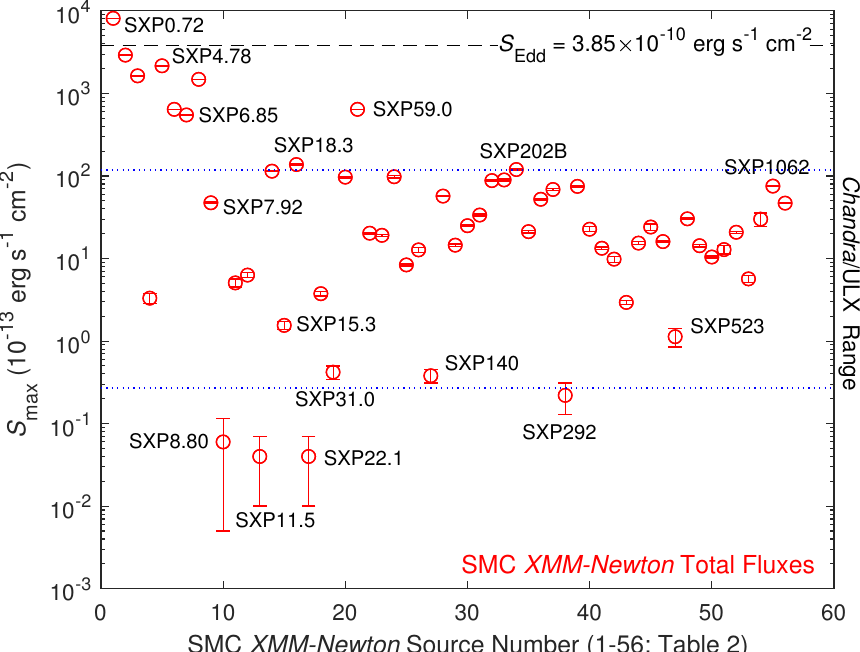
Figure 5. Sample of maximum X-ray fluxes for the SMC XMM-Newton sources in Table 2 (all 3 EPIC cameras combined). Errors are small in all but the 3 faintest sources. The range of ULX data and SMC Chandra data is virtually the same, and it is marked by the dotted lines. The Eddington flux S Edd for the SMC is also shown as a dashed line. Here S Edd = L Edd / ( 4 π d 2 ) = 3.85 × 10 − 10 erg s − 1 cm − 2 , where we used L Edd = 1.77 × 10 38 erg s − 1 for a canonical neutron star with mass 1.4 M (cid:12) and a distance of d = 62 kpc to the SMC